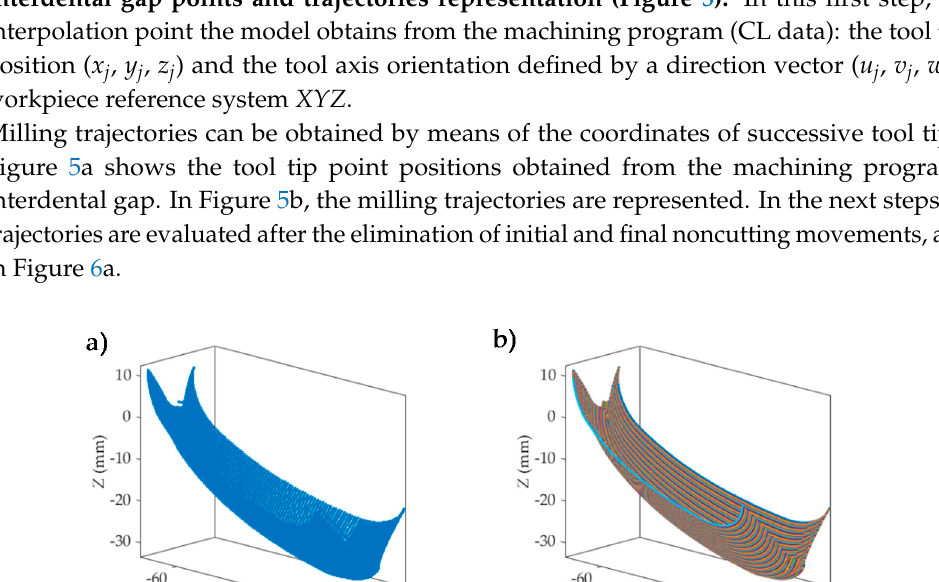
Figure 5. Interdental gap points ( a ) and trajectories ( b ) representation.